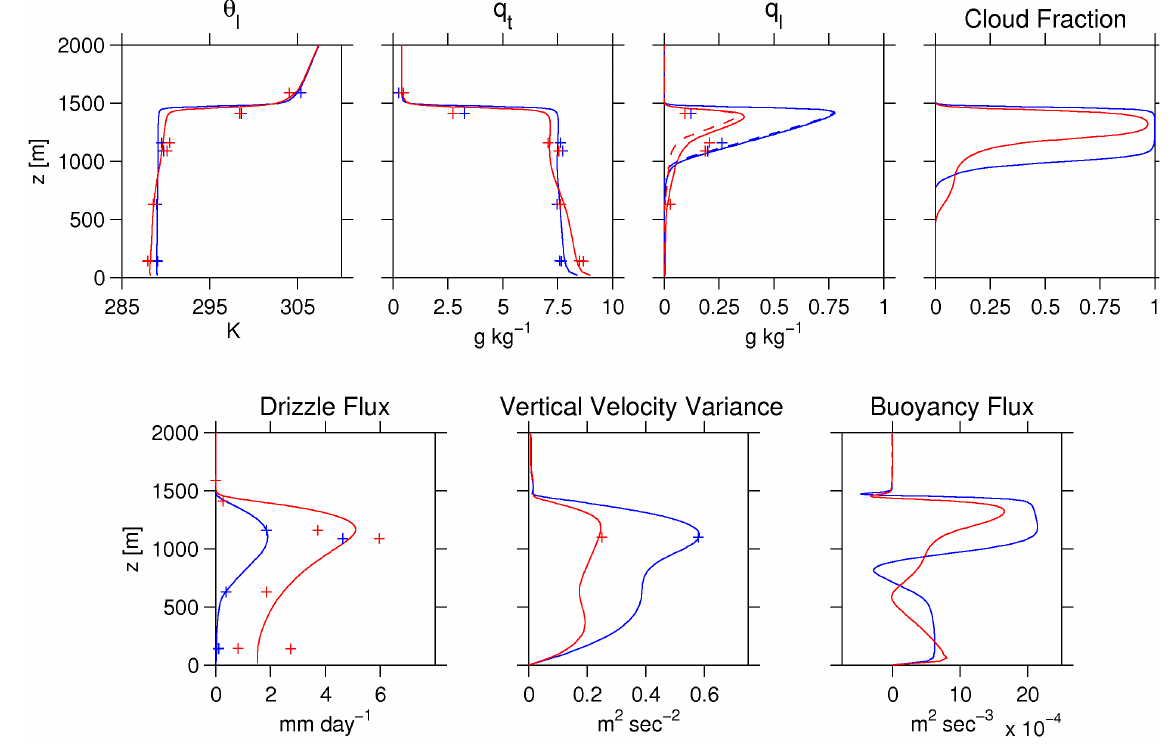
Fig. 8. Region and time averaged profiles for the OVC (blue) and POC (red) regions during the 02:00–04:00 LST comparison period. Flight-leg means from RF06 subset by region are overplotted for reference.